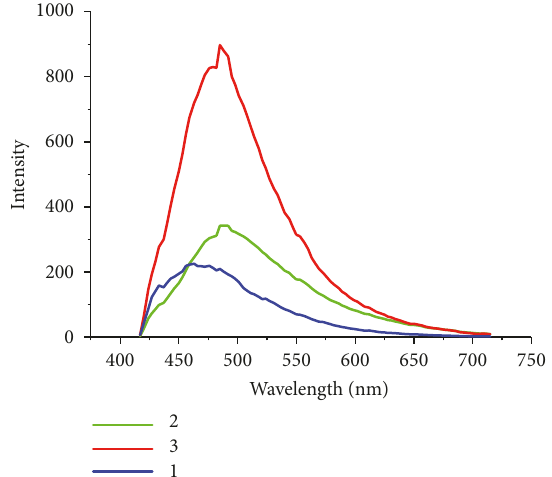
Figure 5: Luminescence spectra of the ACAIN-containing polymer films, compositions 1, 2, and